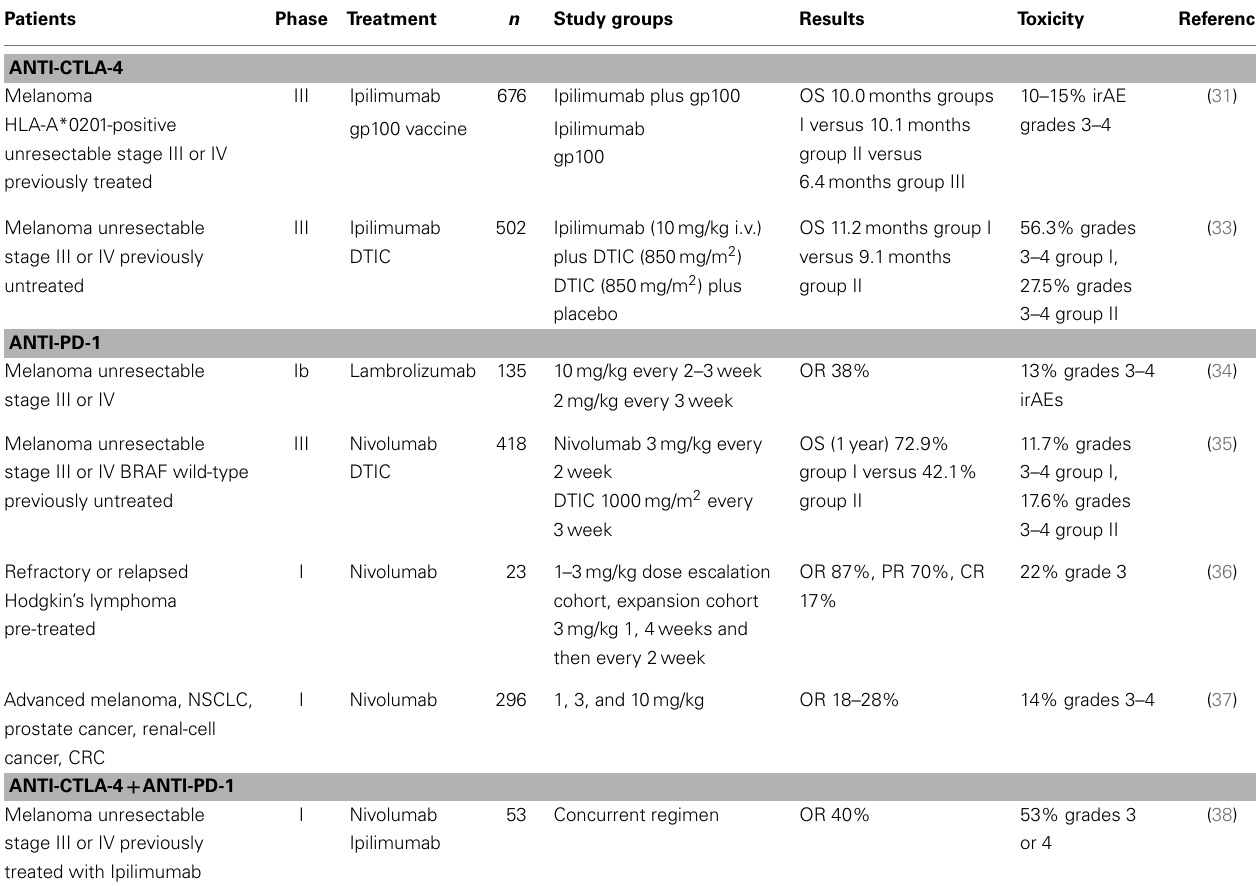
Table 1 | Selected clinical trials with anti-checkpoint mAbs